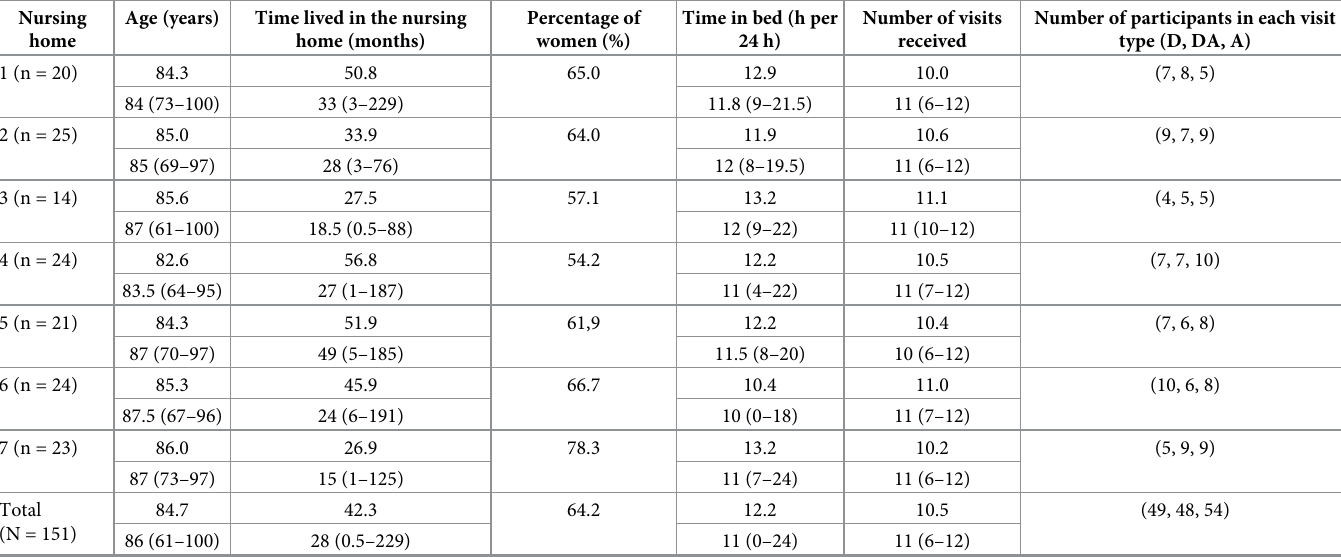
Table 3. Description of the study population.